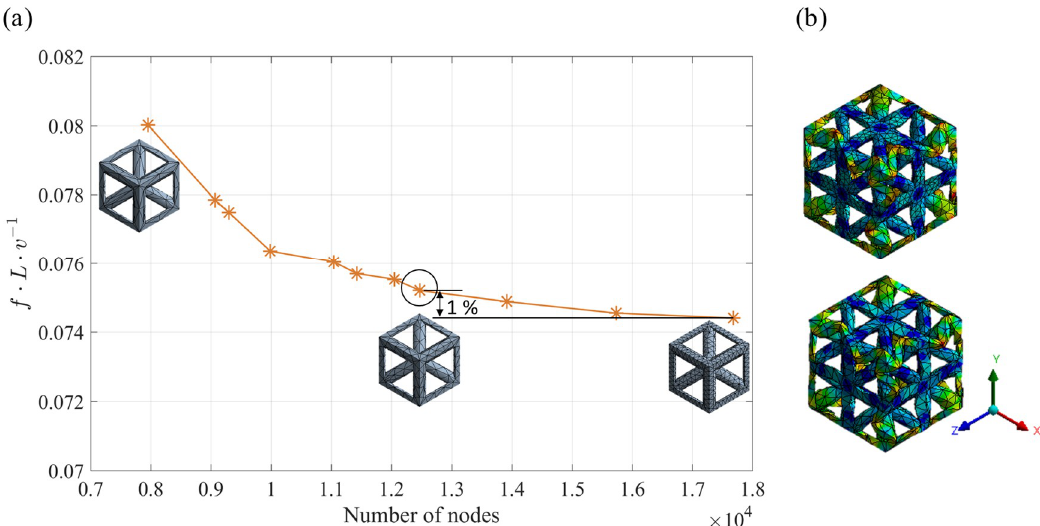
Figure 5. ( a ) Convergence results of the first natural frequency with respect to the mesh density of a 2 × 2 × 2 BCC xyz lattice (converged mesh density is highlighted) and ( b ) comparison of high frequency vibration modes (existing above a normalised frequency of 0.3) of converged mesh (bottom) and finer mesh